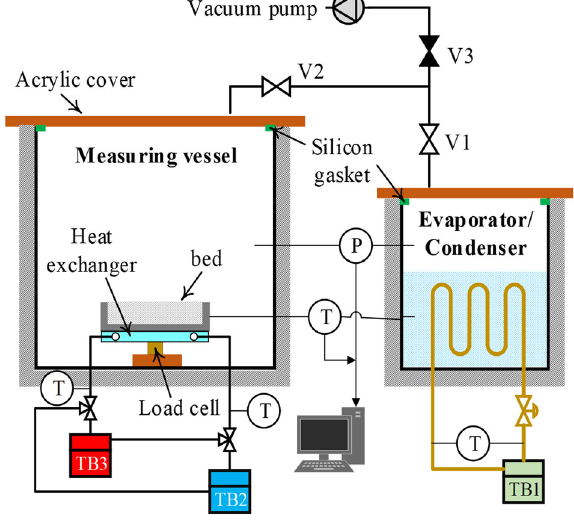
Fig. 11 Graphic description of the experimental setup. It was used to measure the adsorption isotherm and performance of the packed and coated